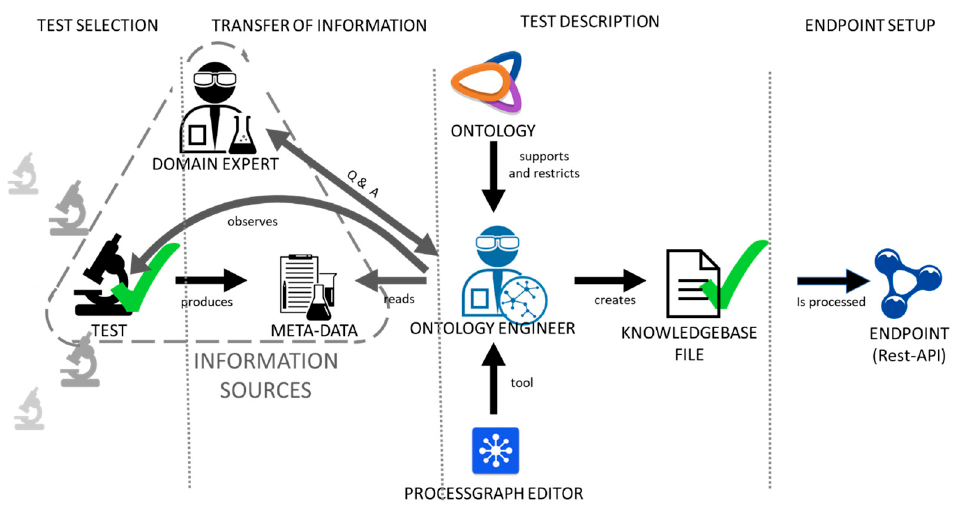
Figure 8. Digital workflow modified to allow ontology elicitation. Placing the ontology engineer (OE) at the center of the Test Description process only responds to the need to critically analyze and document the semantic transformation depicted in the Figure 6.